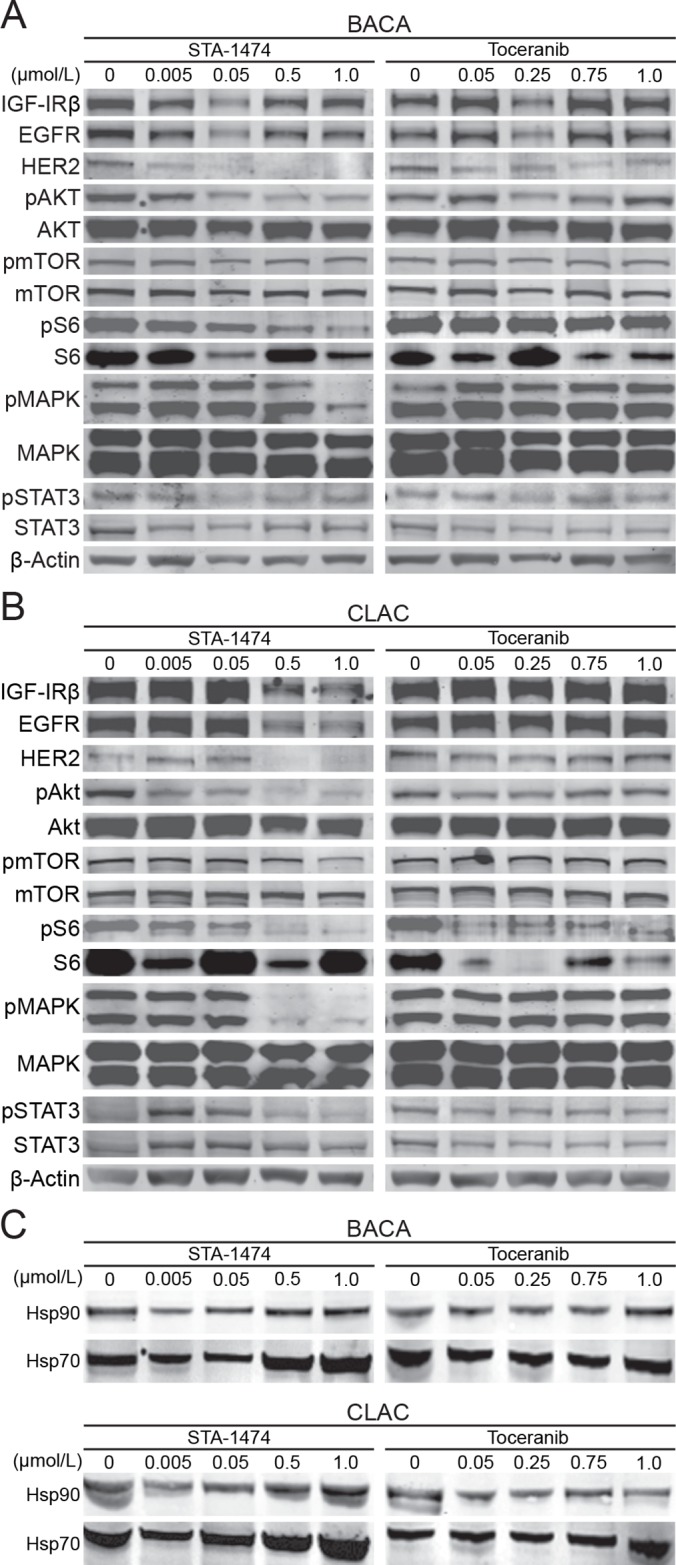
Protein expression of HSP90-regulated proteins, HSP70 and HSP90 in canine lung cancer cell lines after treatment with small molecule inhibitors.A set of three plates for each cell line was used for evaluation of total and phosphoproteins of downstream signaling pathways (A) Representative immunoblots of HSP90 client protein expression from BACA whole cell protein lysates after treatment with STA-1474 or toceranib phosphate. (B) Representative immunoblots of HSP90 client protein expression from CLAC whole cell protein lysates after treatment with STA-1474 or toceranib phosphate. Controls were cell lines treated with the drug solvent, DMSO, as represented by the 0 concentration. Evaluation of phosphoprotein forms of the proteins are indicated by “p”. Drug concentrations are μmol/L. The β-actin Western blots serve as loading controls. (C) Immunobloting from whole cell protein lysates of HSP70 and HSP90 of BACA and CLAC lines treated with DMSO (control), STA-1474 and toceranib phosphate.